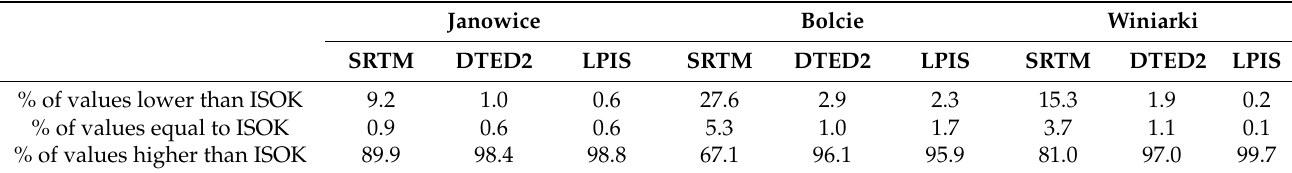
Table 16. Comparison of sum of the total LS factors values in the agriculture plots calculated on the basis of the DTMs SRTM, DTED2 and LPIS against the sum of the total LS factors values calculated on the basis of the DTM ISOK in the 3 research areas (in %).